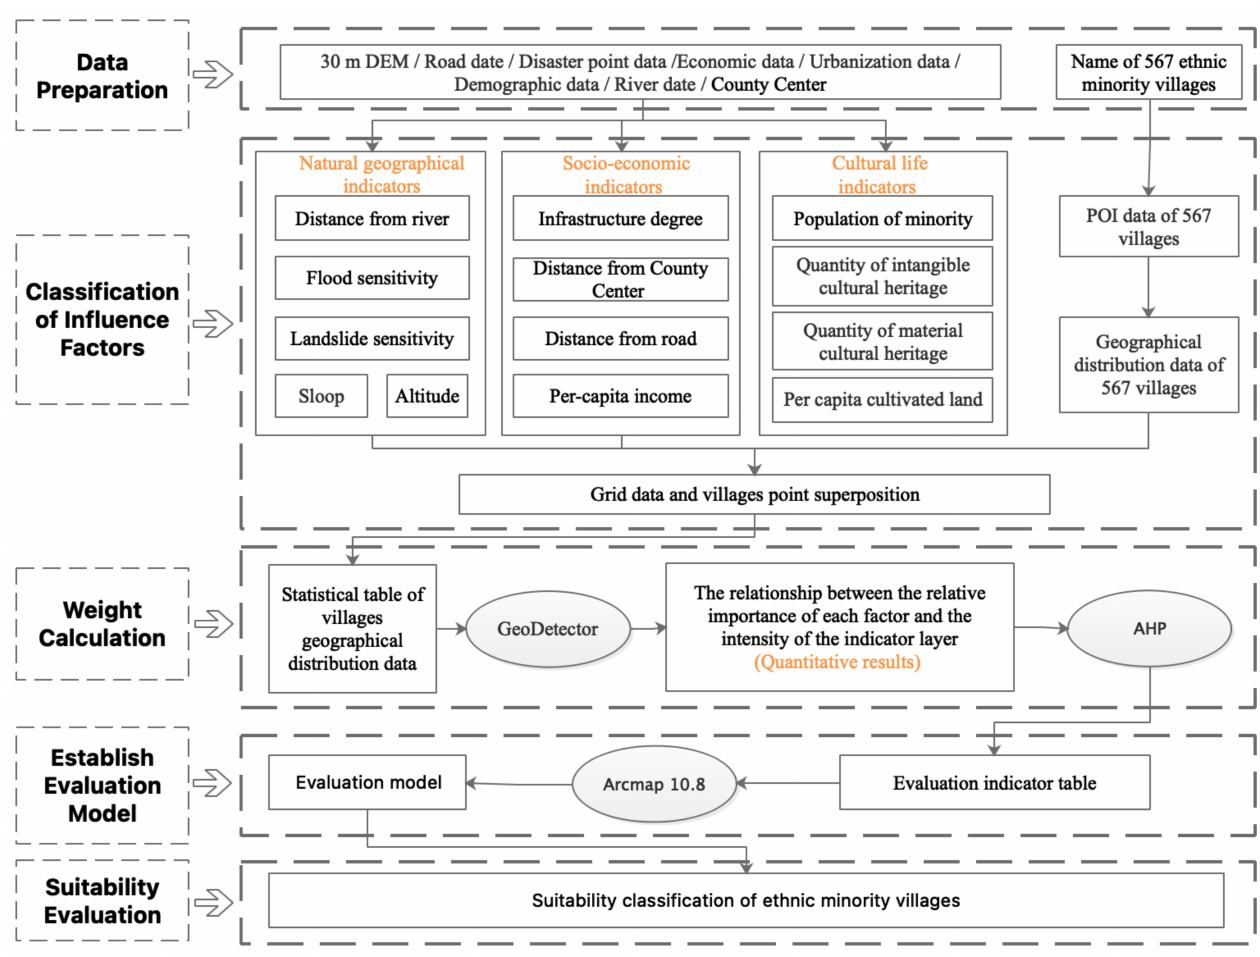
Figure 4. The overall flowchart of the